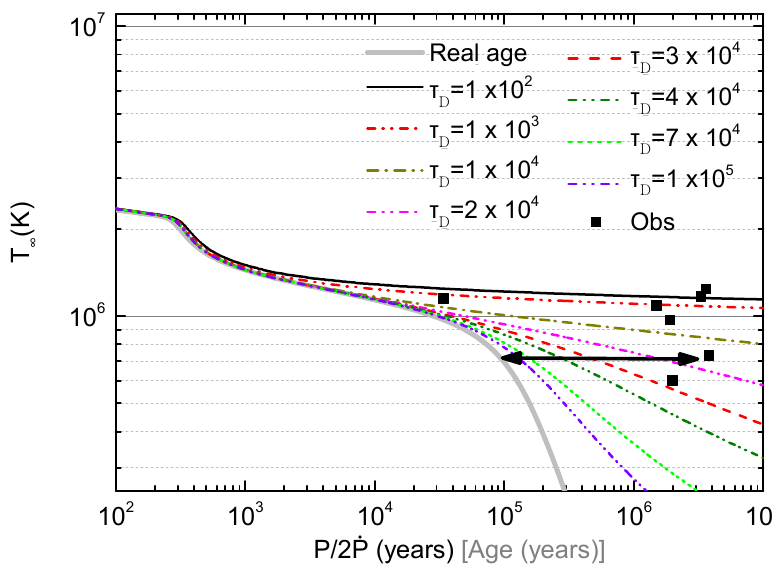
Figure 9. Thermal evolution of neutron stars whose magnetic field evolve according to Figure 7. With the exception of the washed gray curve, which shows the real age, the curves represent the temperature as observed by an observer at infinity as a function of the spin-down age ( P /2 ˙ P ). We also indicate by the arrow an example of the discrepancy between the true and spin-age (to avoid cluttering the image we only show one